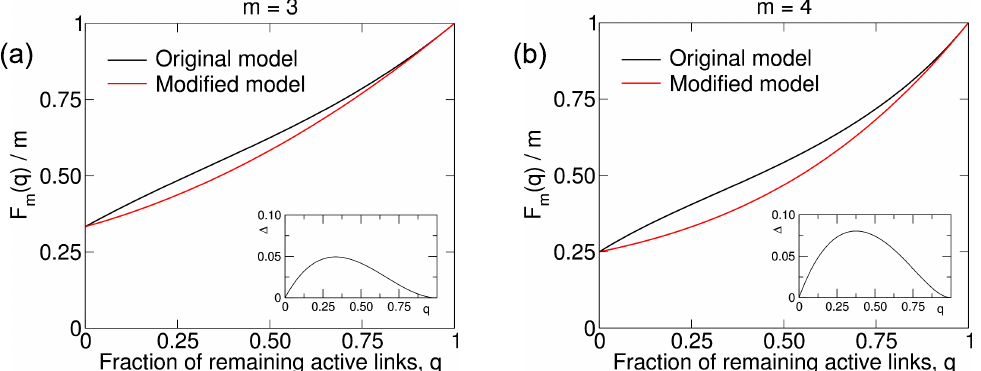
Figure B1. Average number of games that the defector plays in the original model (black curves) and the modified model (red curves). The expected number of exploitations ( q ) /m , is plotted against the probability, q , to normalized by the number of rounds, F m maintain each link when ( a ) m = 3 and ( b ) m = 4 . The inset in each panel shows the difference, ∆ , between the black and red